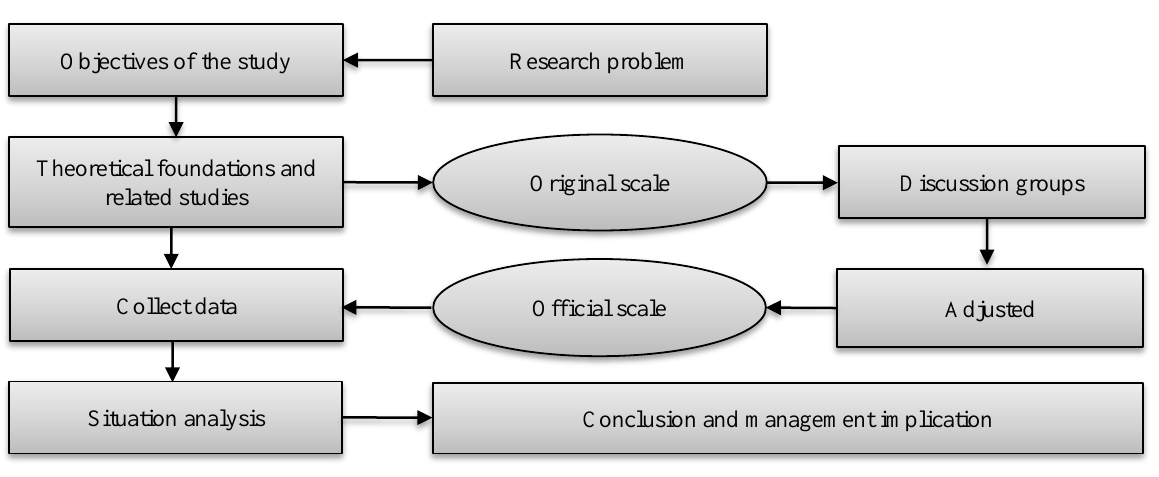
Figure 1. The research process for the competitive capacity of SMEs in